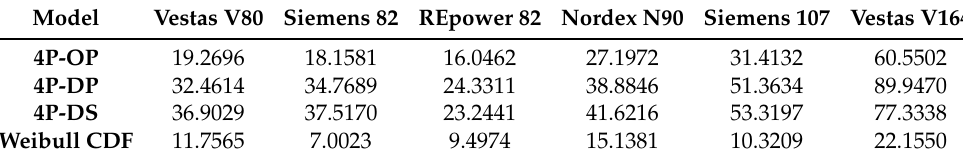
Table 4. Comparison of MAE values for several